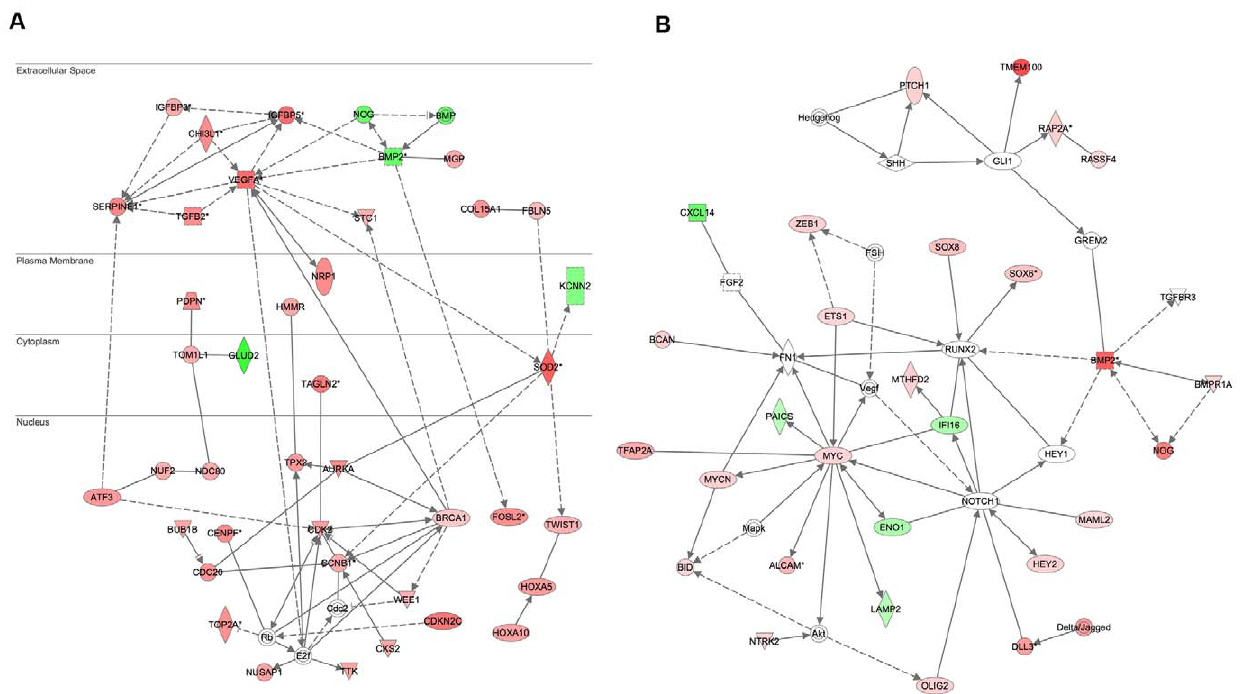
Figure 3. Network analysis of genes differentially expressed between low- and high-grade proneural gliomas identifies regulatory hubs. ( A ) Protein interaction network generated by Ingenuity Pathway Analysis (IPA) of the 576 probes differentially expressed between Proneural GBM and Proneural Oligodendrogliomas/Astrocytomas. Proteins marked in red are increased in Proneural GBM samples, and those in green are decreased, relative to Proneural low grade gliomas. Solid lines represent direct interactions, and dashed lines represent indirect interactions. All interactions are derived on the Ingenuity Knowledgebase, which is extracted from the PubMed literature. ( B ) Protein interaction network based on IPA analysis of 129 genes differentially expressed between PN-Oligodendrogliomas and Classic and Neural Oligodendrogliomas. Network hubs are readily discernible around the Notch receptor, Myc oncogene, and the GLI1 transcription factor.